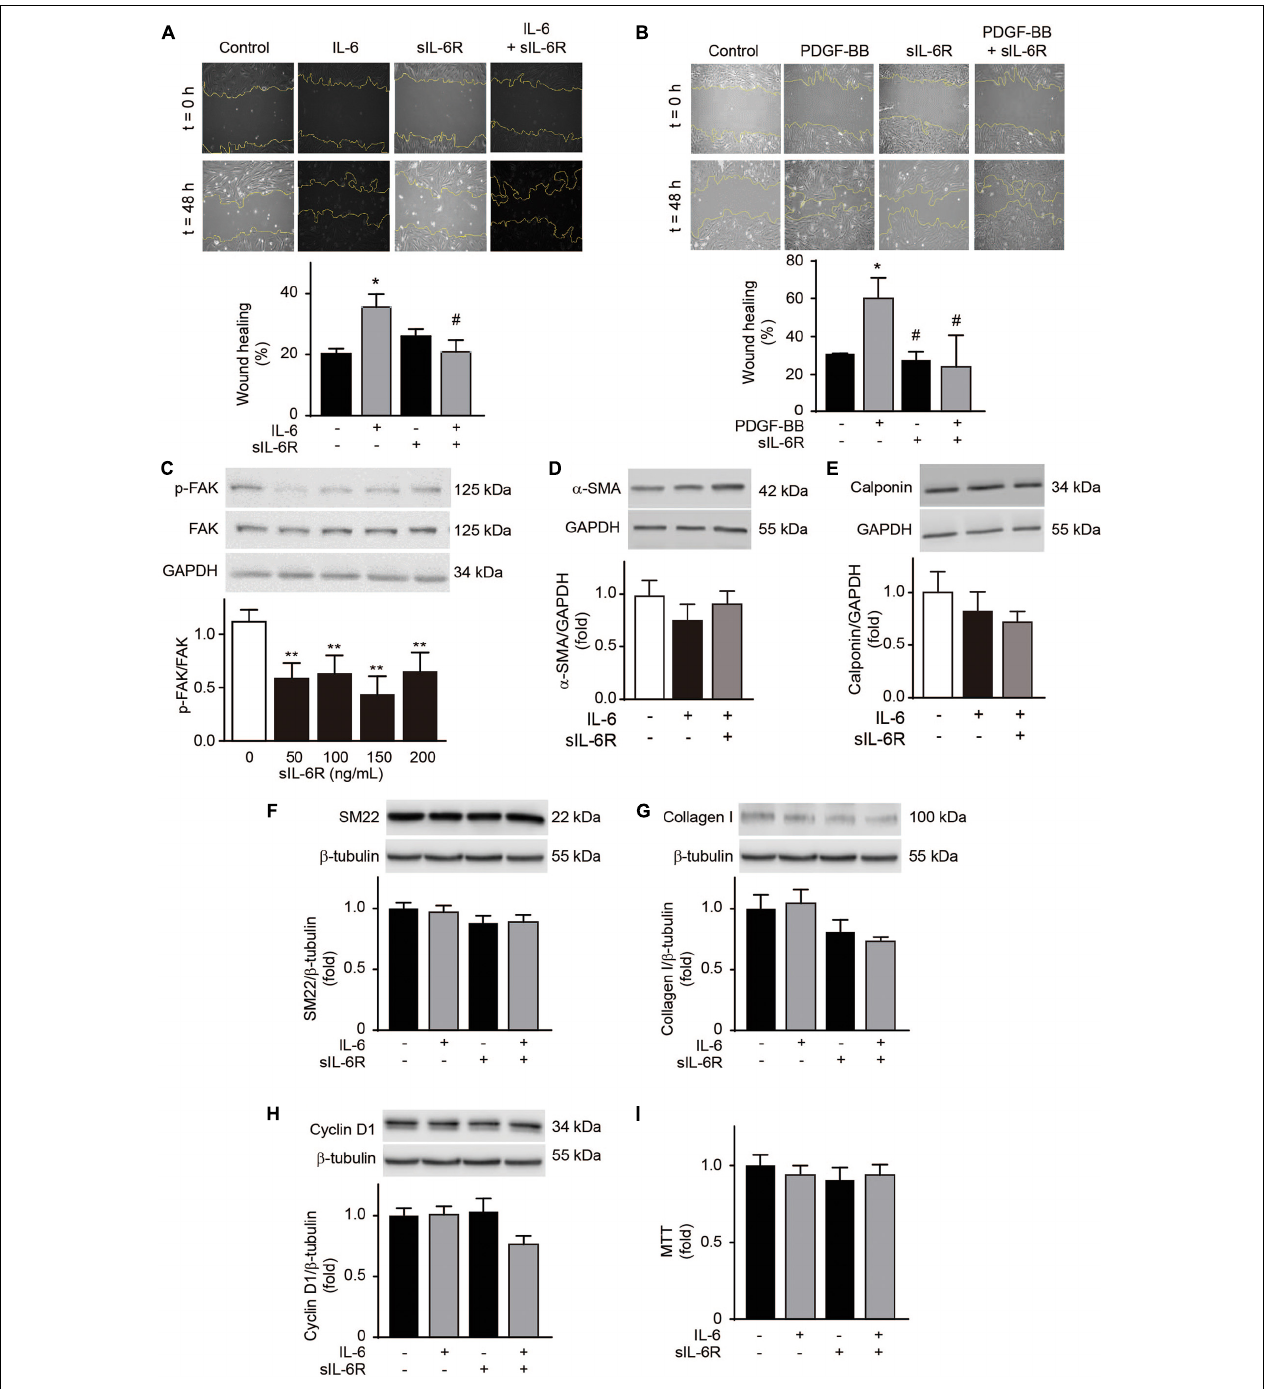
FIGURE 5 | Soluble interleukin-6 receptor (sIL-6R) inhibits interleukin-6 (IL-6)-induced A7r5 vascular smooth muscle cell migration. (A) A7r5 VSMCs were treated with 300 ng/mL IL-6, 300 ng/mL sIL-6R, or 300 ng/mL IL-6 + 300 ng/mL sIL-6R. (B) A7r5 VSMCs were treated with 20 ng/mL PDGF-BB, 300 ng/mL sIL-6R, or 20 ng/mL PDGF-BB + 300 ng/mL sIL-6R. Wound healing (%) after 24 h was measured using ImageJ software ( n = 5). (C) A7r5 VSMCs were treated with 300 ng/mL sIL-6R for 1 h. Phosphorylated focal adhesion kinase (p-FAK) and total FAK were determined by Western blotting. GAPDH was used as a loading control. (D–I) A7r5 VSMCs were treated with 300 ng/mL IL-6, 300 ng/mL sIL-6R, or 300 ng/mL IL-6 + 300 ng/mL sIL-6R for 24 h. α -smooth muscle actin ( α -SMA) (D) , calponin levels (E) , SM22 (F) , collagen type I (G) , and cyclin D1 (H) were determined by Western blot. GAPDH and β -tubulin were used as a loading control. Upper panels are representative images. Lower panels are measurements ( n = 4). (I) Cell proliferation was measured using the MTT assay ( n = 4). Data represent mean ± SEM and were analyzed using one-way ANOVA followed by Holm-Sidak’s multiple comparisons test in panels (C–E) ; and two-way ANOVA followed by post hoc Sidak test in panels (A,B,F–I) . * p < 0.05, ** p < 0.01 vs. control; # p < 0.05 vs. PDGF-BB.